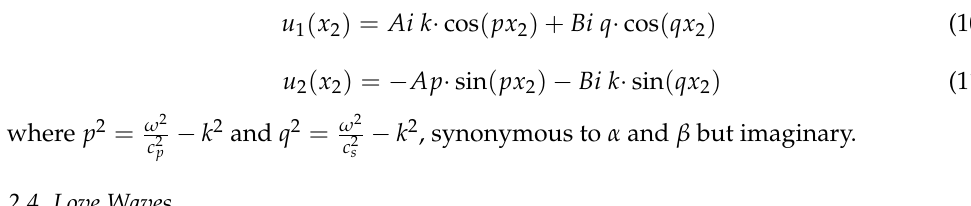
Table 1. Table describing types of waves and materials to be used .